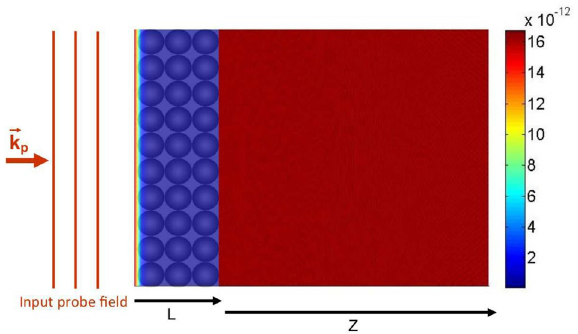
Figure 4. The propagation of the probe field amplitude inside the QDM medium, | E p ( x , z )/ E p ( 0 ) | , and outside it, | ψ p ( X , Z )/ E p ( 0 ) | , in the absence of the tunneling effect, T e = 0 . Used parameters are � c 0 = 0.5 Ŵ , d = 10 µ m , (cid:31)